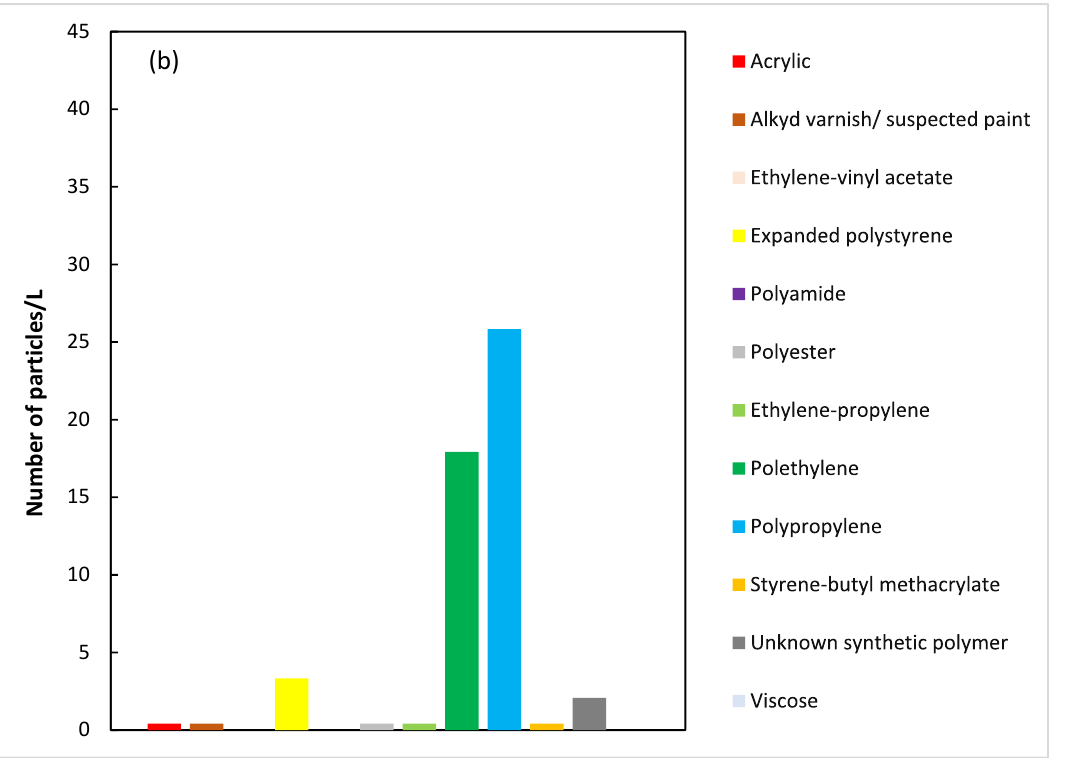
Figure 3. ( a ) Type and total concentration of microplastic particles in the untreated sample; ( b ) type and total concentration of microplastic particles in the treated sample.